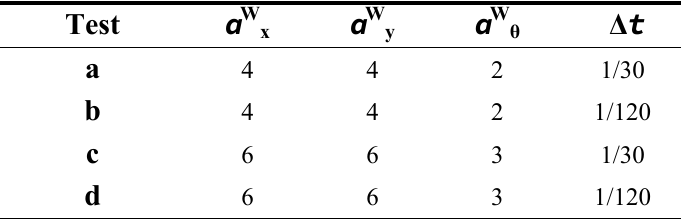
Table 2. Setup of the tests.